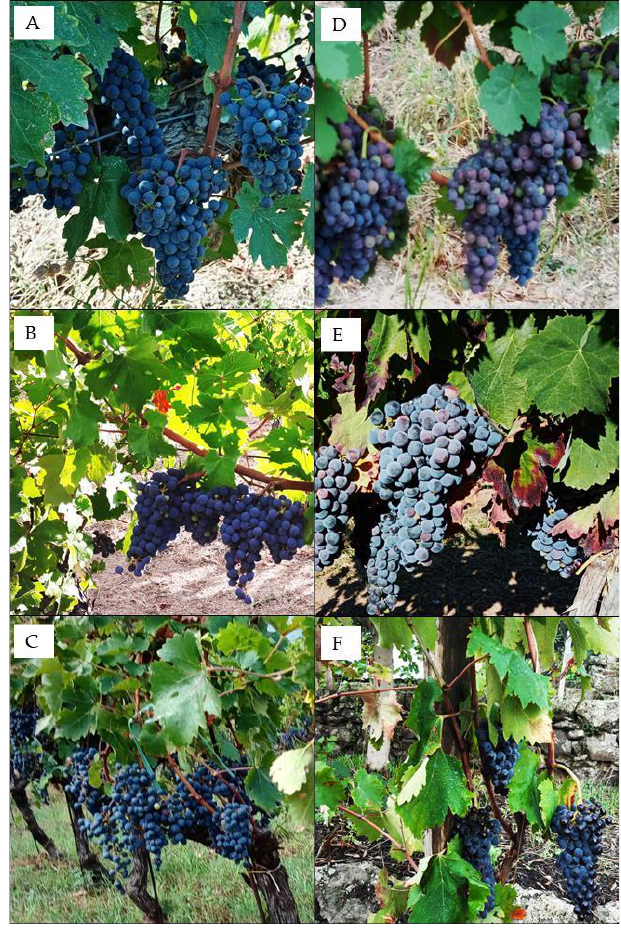
Figure 9. Bunches of the two cultivars, Cabernet Sauvignon (CAB) and Aglianico (AGL), grown in three different sites, Molise (MOL), Campania (CAM), and Sicily (SIC). (A): CAB MOL; (B): CAB three different sites, Molise (MOL), Campania (CAM), and Sicily (SIC). ( A ): CAB MOL; ( B ): CAB CAM; (C): CAB SIC; (D): AGL MOL; (E): AGL CAM; (F): AGL SIC. CAM; ( C ): CAB SIC; ( D ): AGL MOL; ( E ): AGL CAM; ( F ): AGL